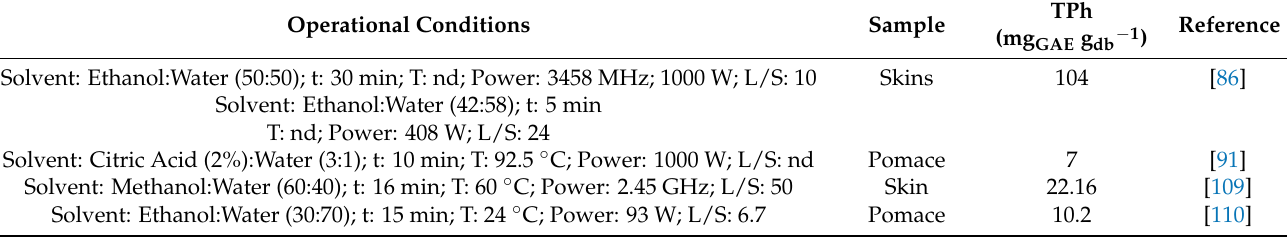
Table 8. Summary of microwave-assisted extraction for the recovery of phenolic compounds from winery